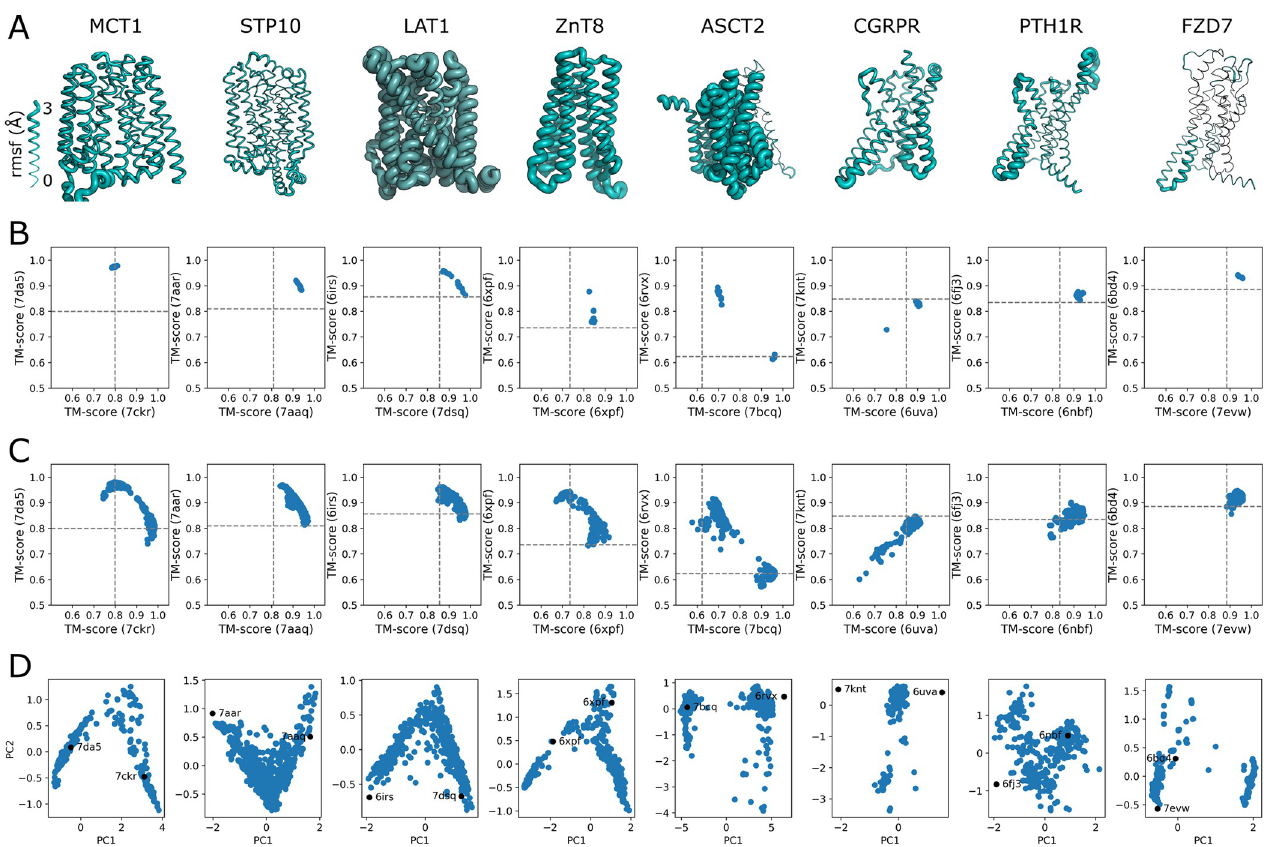
Fig 4. Sampling conformational flexibility of proteins with no structures in AF2 training set. A) Models with the thickness of the chain based on the rmsf for the 15 AF2 models from the unmodified MSA. B) TM score plot for the 15 initial models. C) TM score plot for all models after parsing for molprobity score. D) PCA of the parsed models. In Fig D in S1 Text are plots of the experimental structures and the best model based on TM score.